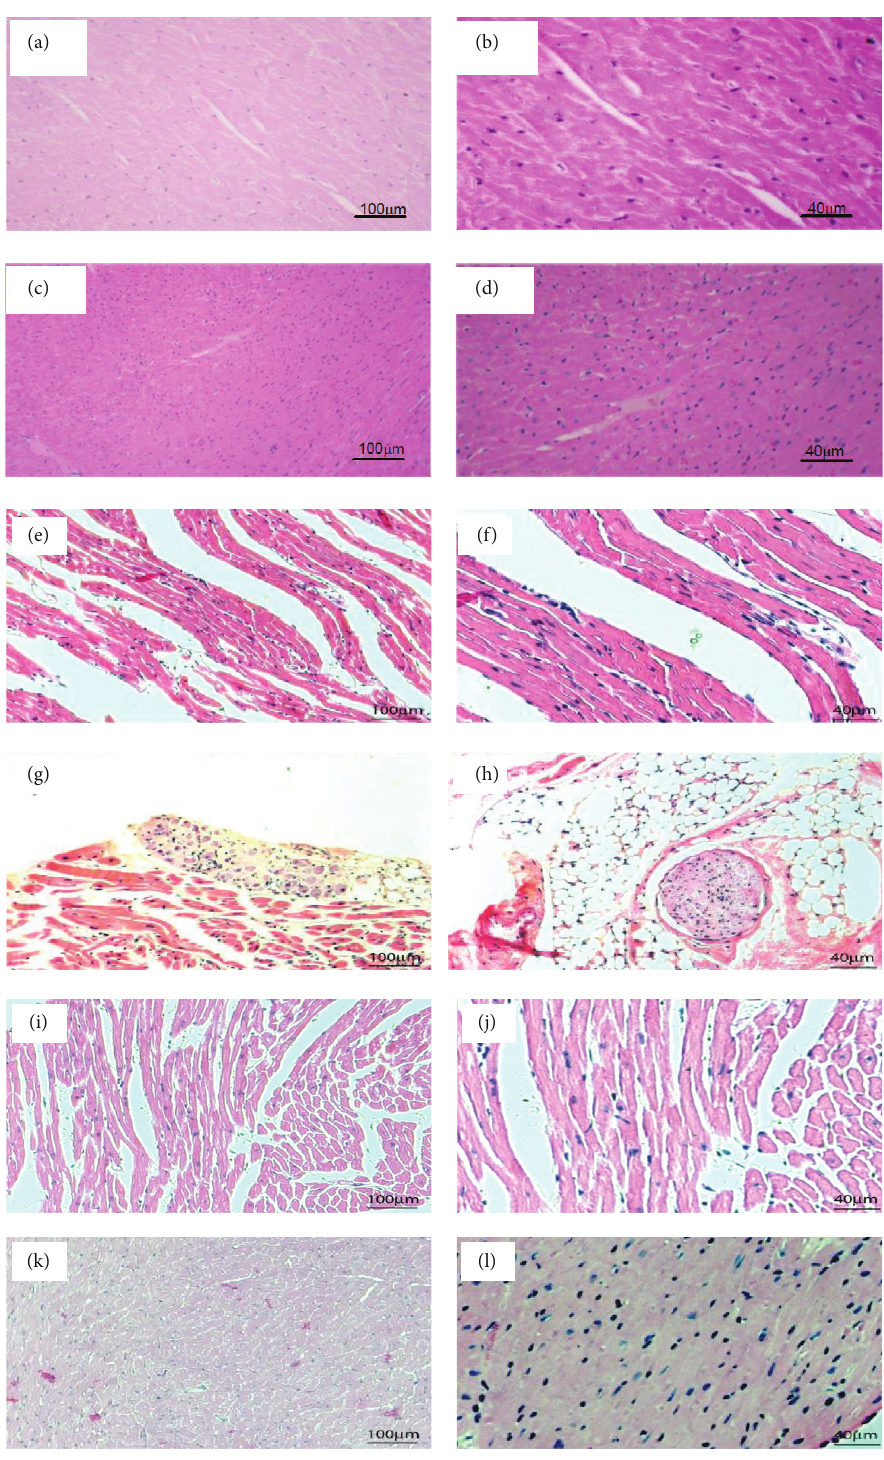
Figure 3: Cardiac histopathology after treatment with pyridostigmine bromide. Photomicrographs of cardiac sections stained with H-E. Panels (a) and (b): ventricular sections from a control nontreated mouse. Panels (c) and (d): ventricular sections from a pyridostigmine bromide-treated control mouse. Panels (e) and (f): ventricular sections from a chagasic nontreated mouse. Panels (g) and (h): atrial sections from a nontreated chagasic mouse showing, respectively, a ganglionitis and neuritis focus. Panels (i), (j), (k), and (l): different ventricular sections from a chagasic mouse treated with pyridostigmine bromide. Note the lower inflammatory infiltration into heart tissues from a chagasic mouse treated with pyridostigmine bromide. (Left panels: magnification = 100x; right panels: magnification =